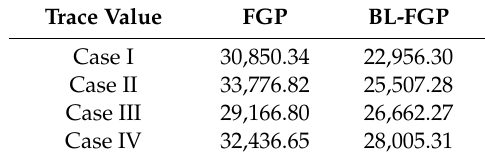
Table 4. Trace value of the cases.